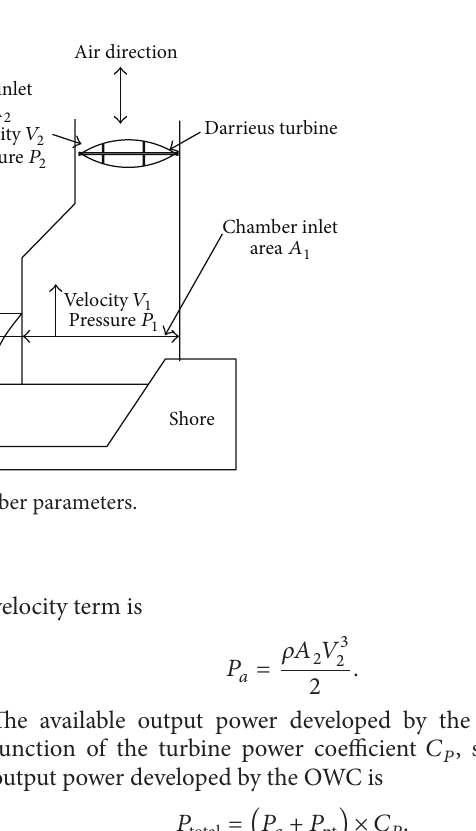
Figure 5: The Simulink diagram of the PV model with MPPT. (a) PV Simulink model; (b) MPPT model; (c) complete Simulink PV model with MPPT.